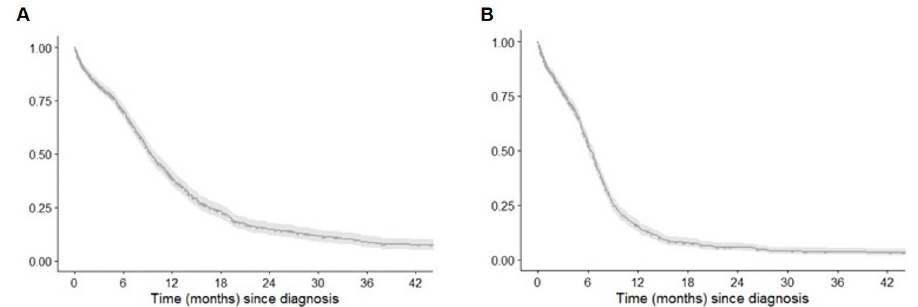
Fig 1. Overall survival (A) and progression-free survival (B) in the study